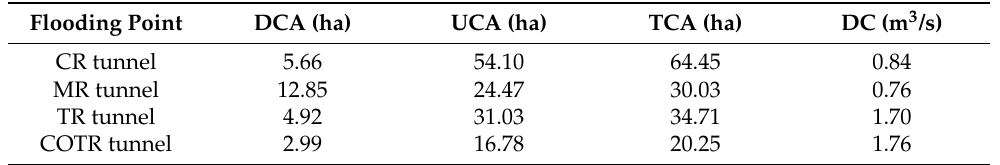
Figure 4. Photographs depicting the ( a ) CR tunnel, ( b ) MR tunnel, ( c ) TR tunnel, and ( d ) COTR tunnel. Table 3. Direct Catchment Area (DCA), Upstream Catchment Area (UCA), Total Catchment Area. (TCA), and Drainage Capacity (DC) of the four selected flooding point.